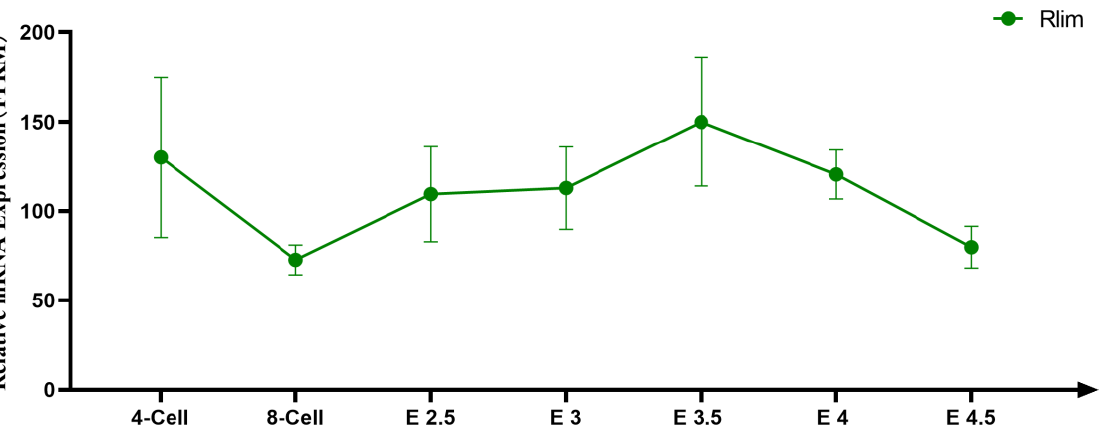
Figure 1. Schematic representation of Rlim mRNA expression level in female embryos during early developmental stages, from 4-cell stage to embryonic days 4.5. Data on Rlim mRNA expression levels in female embryos at early developmental stages were obtained from publicly available data from the study by Wang et al. [22].